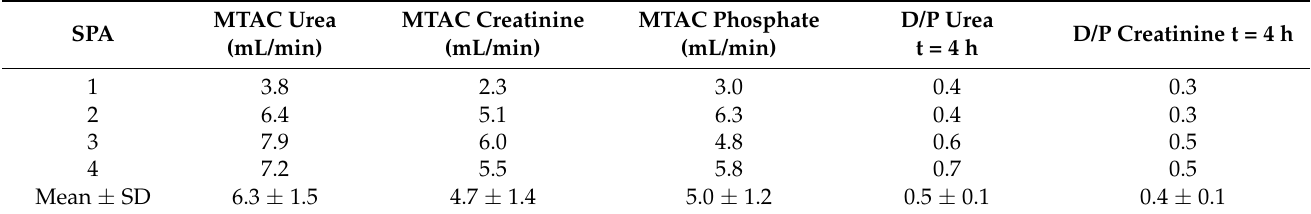
Table 2. Results of the standard peritoneal permeability analysis in goats ( n =